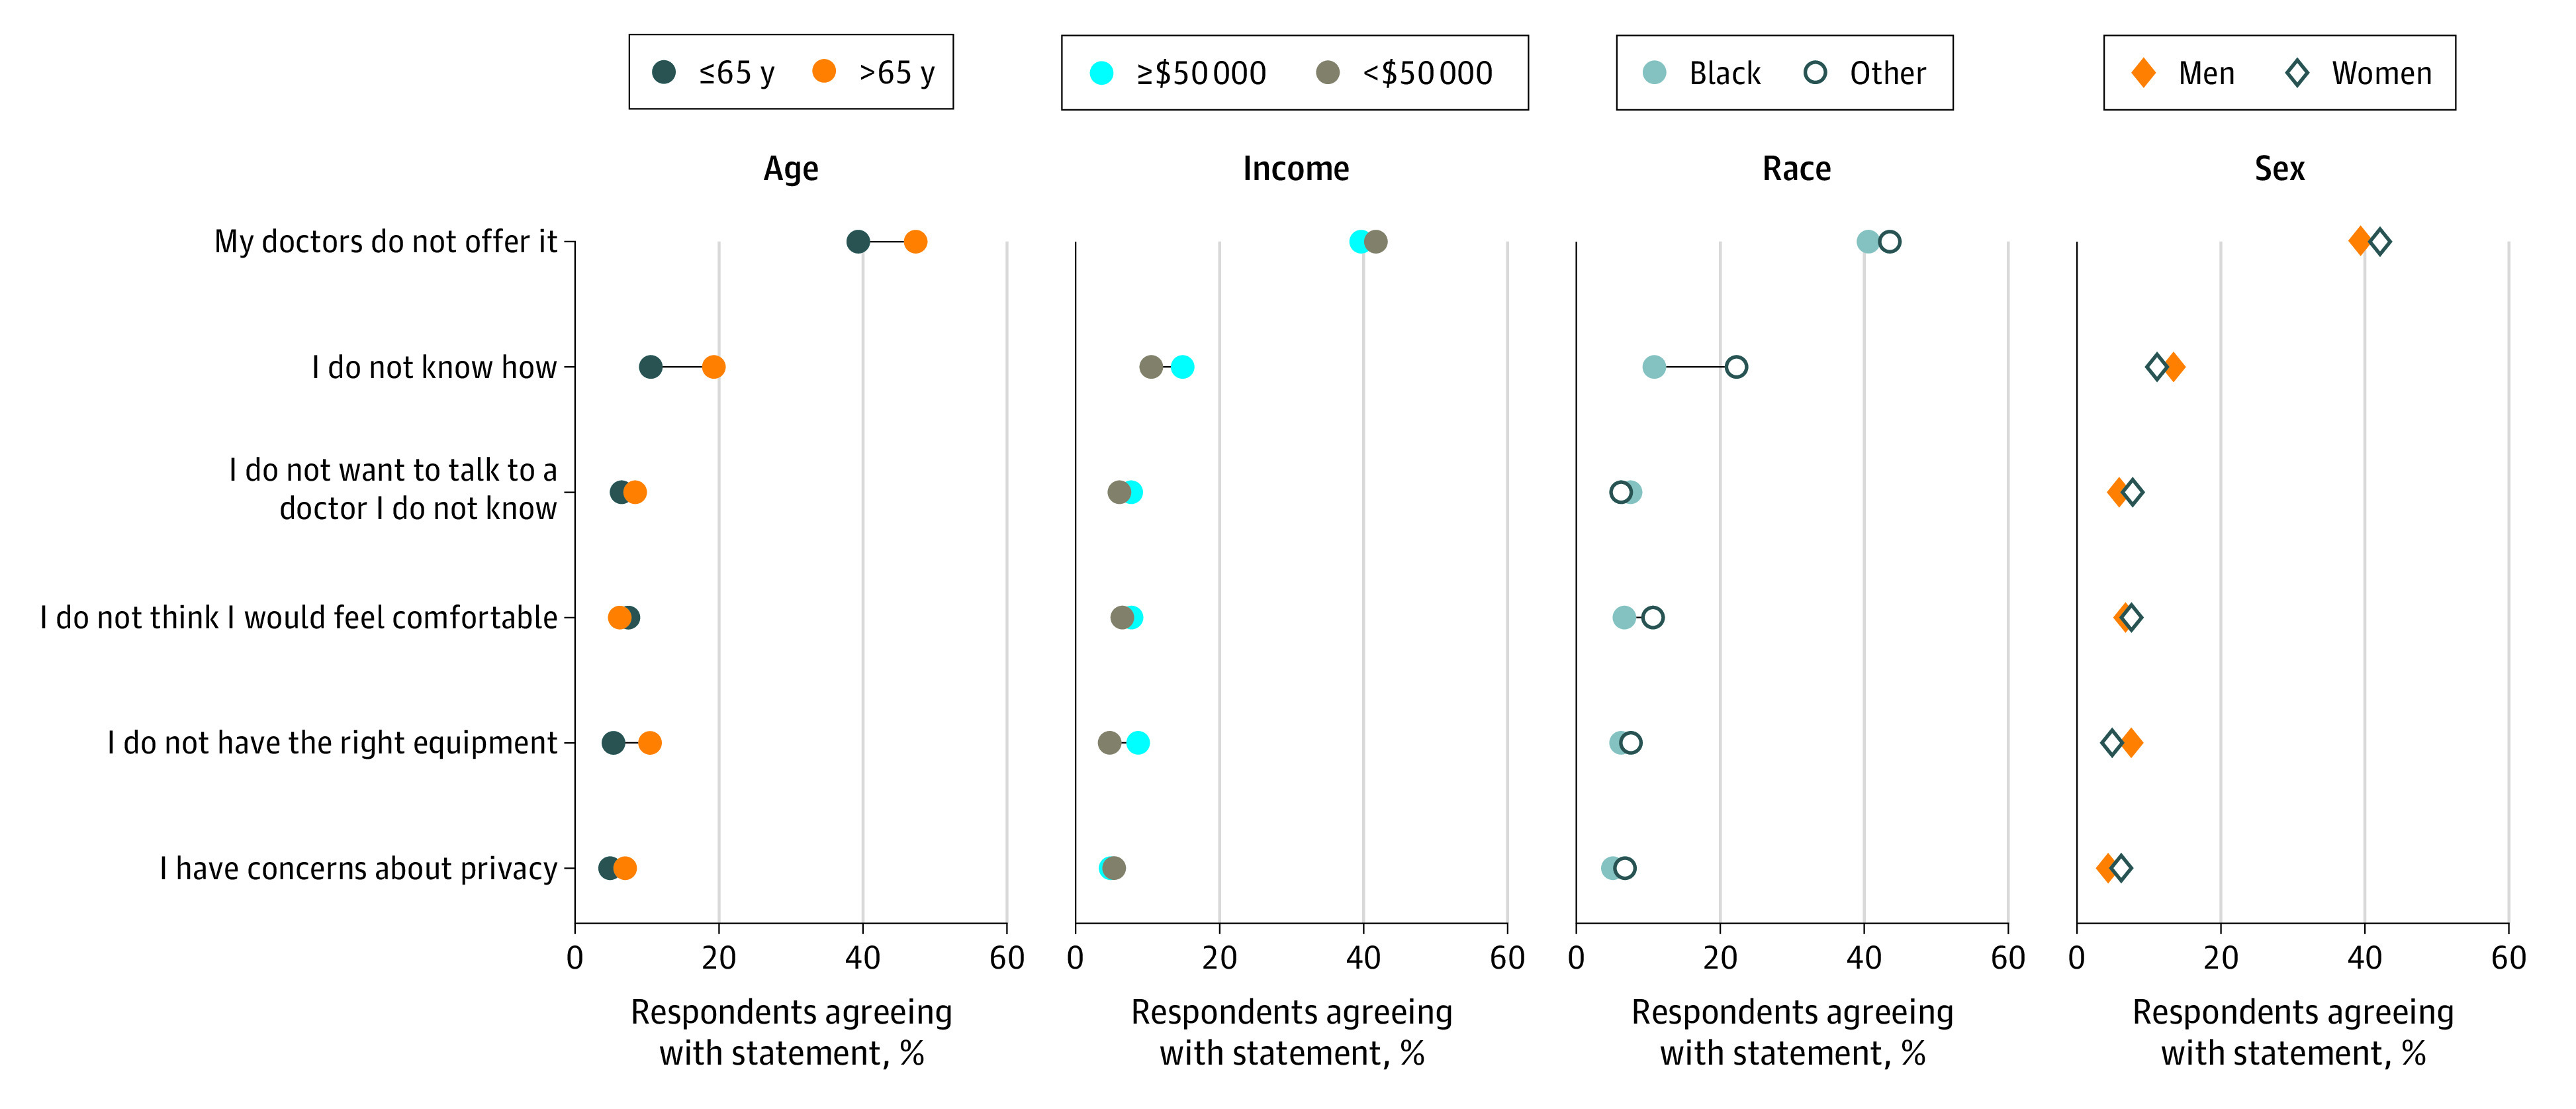
Reasons for Not Using Videoconferencing by Demographic GroupRespondents could answer with more than 1 reason.